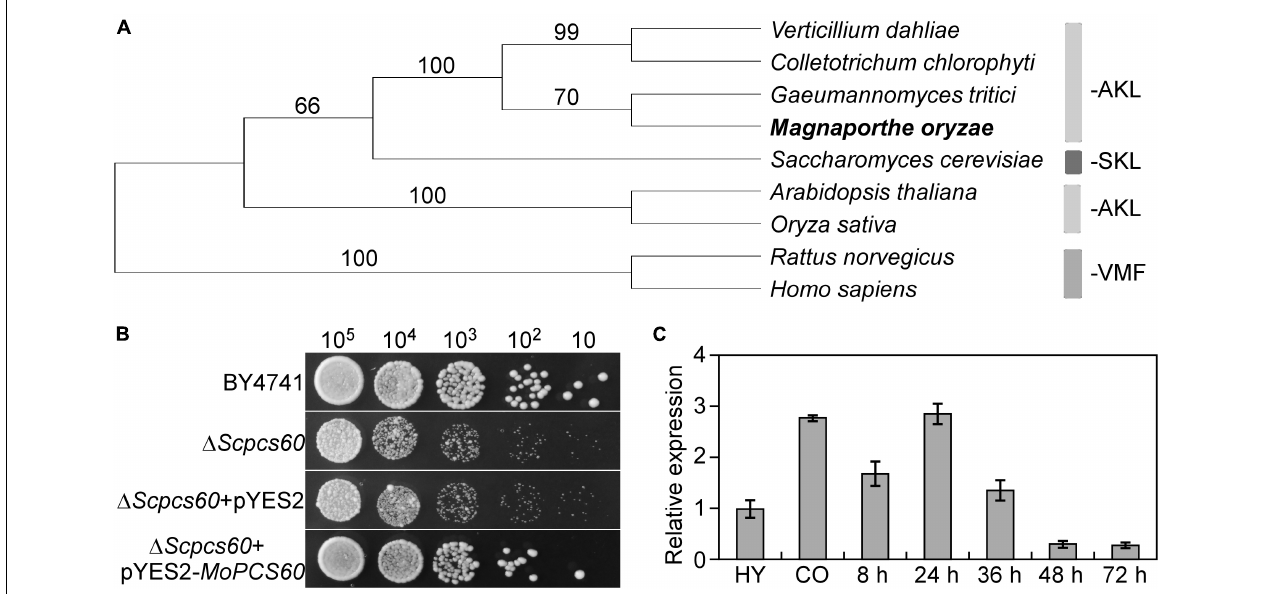
FIGURE 1 | Phylogenetic analysis, yeast complementation, and expression profiles of MoPCS60 . (A) Phylogenetic trees of MoPcs60 proteins from different organisms were constructed using the CLUSTAL_W and MEGA 5.1 programs by the neighbor-joining method with 1000 bootstrap replicates. Species names and GenBank accession numbers are as follows: XP_003712086.1 ( M. oryzae ); OLN86417.1 ( C. chlorophyti ); XP_009223944.1 ( G. tritici R3-111a-1 ); XP_009649893.1 ( V. dahliae ); NP_001438.1 ( H. sapiens ); NP_075243.1 ( R. norvegicus ); NP_001054304.1 ( O. sativa ); NP_190468.1 ( A. thaliana ); NP_009781 ( S. cerevisiae ). AKL and SKL: major PTS1 tripeptides, VMF: minor PTS1 tripeptides. The rice blast fungus was showed in bold. (B) MoPcs60 partially rescued the growth defect of the yeast (cid:49) Scpcs60 mutant. Serial dilutions of BY4741, (cid:49) Scpcs60, and (cid:49) Scpcs60 transformed with pYES2 or pYES2- MoPCS60 were grown on YPG (galactose) with 6 µ g/ml adriamycin plates at 30 ◦ C for 3 days and then photographed. (C) qRT-PCR analyses the expression levels of MoPCS60 at different fungal developmental stages. RNA was extracted from hyphae cultured for 36 h (HY), conidia (CO), and rice leaves inoculated with the wild-type conidia for 8, 24, 36, 48 and 72 h, respectively. Error bars represent the standard deviations of three replicates. TABLE 1 | Phenotypic analysis of Guy11, (cid:49) Mopcs60, and MoPCS60-C strains. Strain Colony diameter (cm) a Conidiation Appressorium Collapsed appressorium (%) d ( × 10 4 /cm 2 ) b formation (%) c CM SDC 1 M 2 M 3 M 4 M Guy11